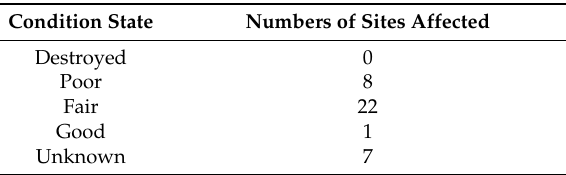
Table 7. Condition state of sites logged at Cyrene.